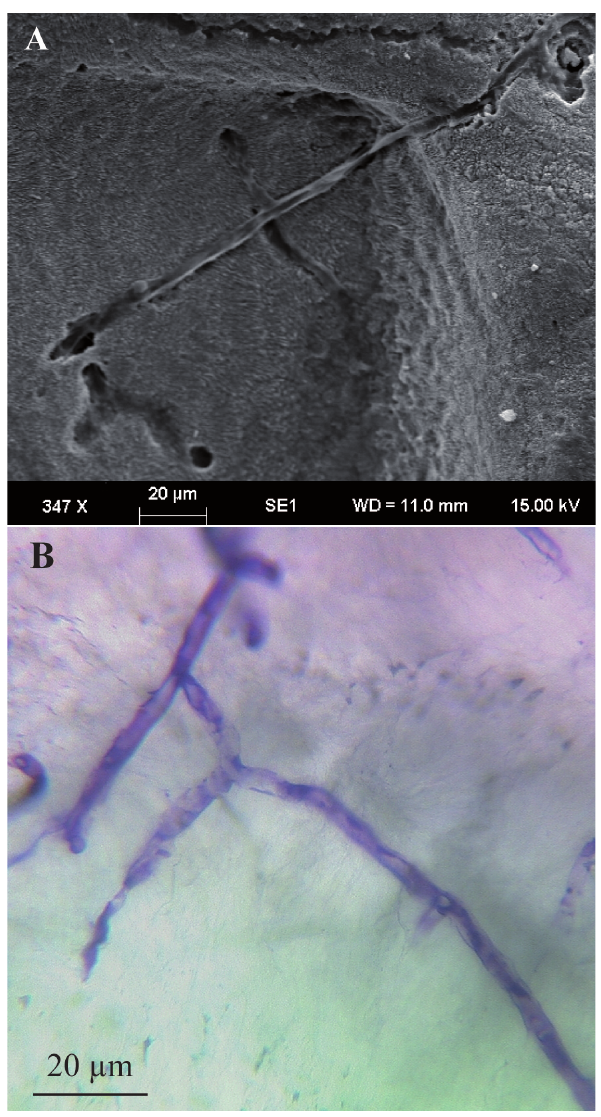
Fig. 1. Filaments of Ostreobium sp. boring inside the skeleton of the coral S. pistillata . (A) : photograph of filament sheet and boring traces taken with an environmental scanning electron microscope. (B) : photograph of live filaments taken with light microscopy.